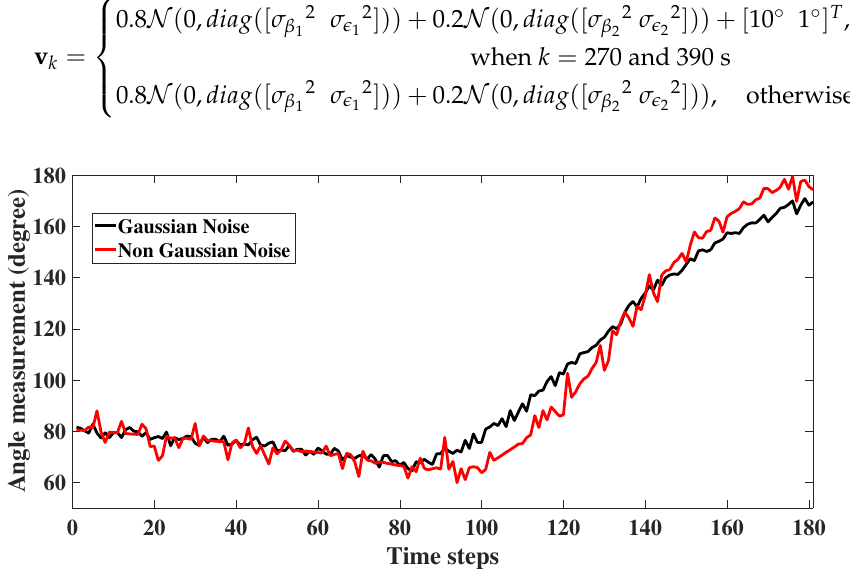
Figure 6. 2D: Angle measurement with glint plus shot